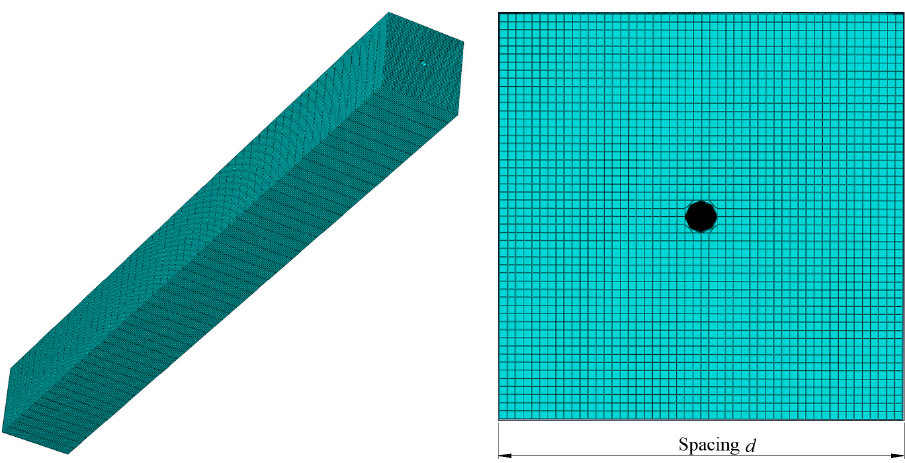
Figure 4. Mesh schematic of the